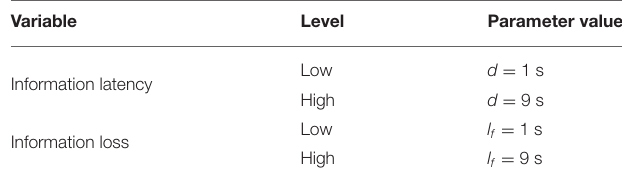
TABLE 2 | Variables used in information latency and